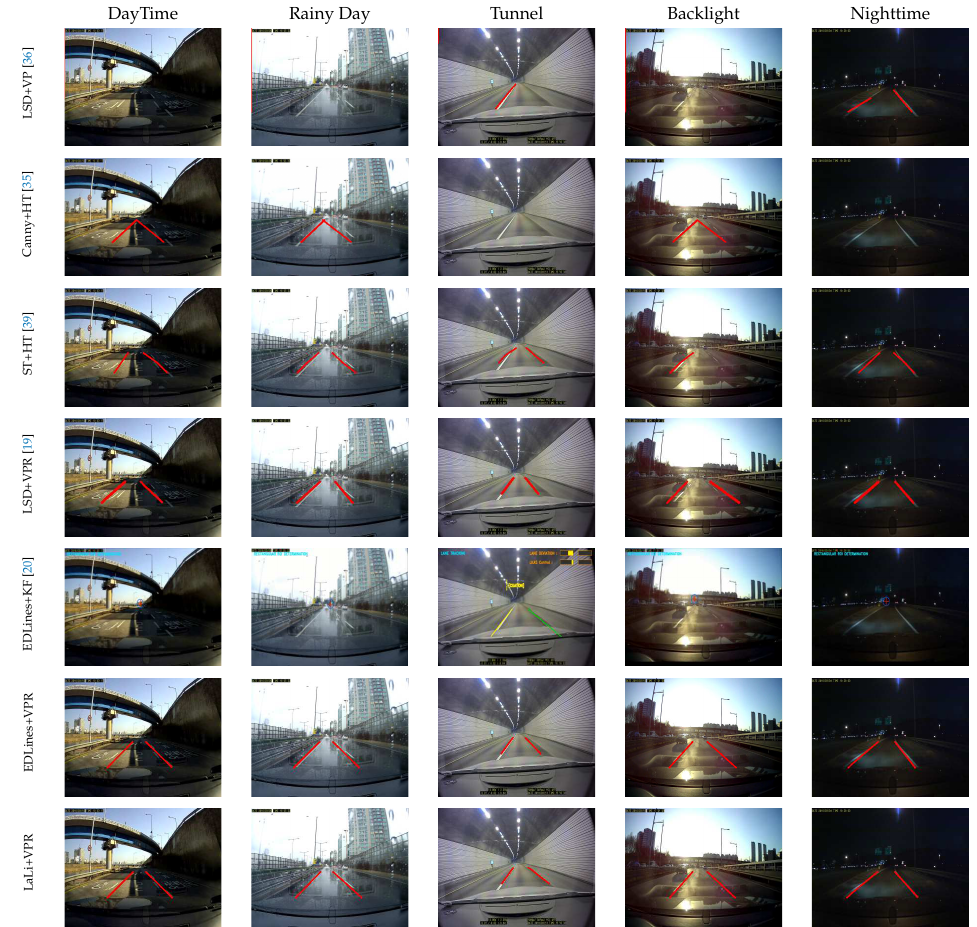
Figure 8. Sample lane detection results on KIST dataset [19]. LaLi+VPR is the lane detection method using the proposed lane-marking